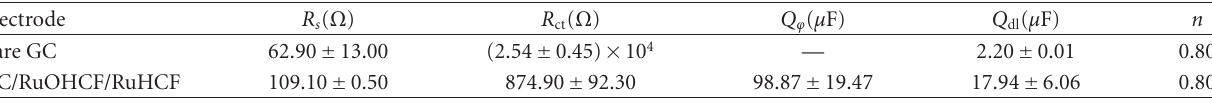
Table 2: Kinetic parameters extracted using the EIS data obtained on the bare GCE and modified GC/RuOHCF/RuHCF electrodes